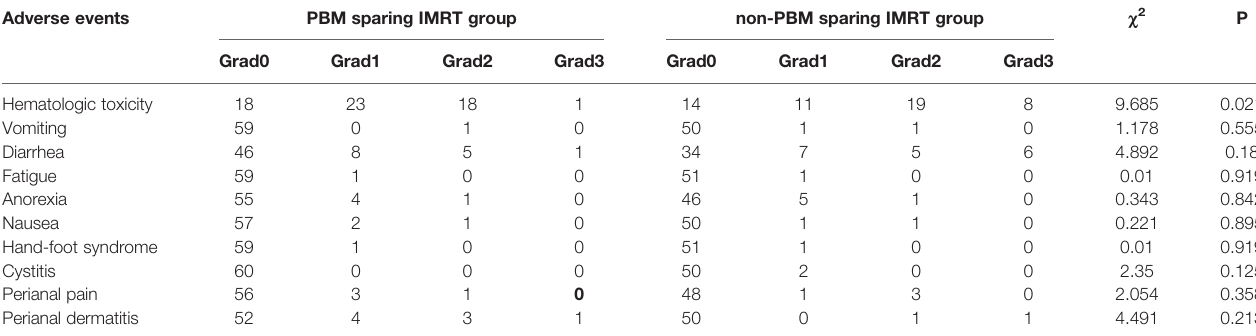
TABLE 5 | Comparison of acute adverse events between PBM sparing IMRT group and non-PBM sparing IMRT group. Adverse